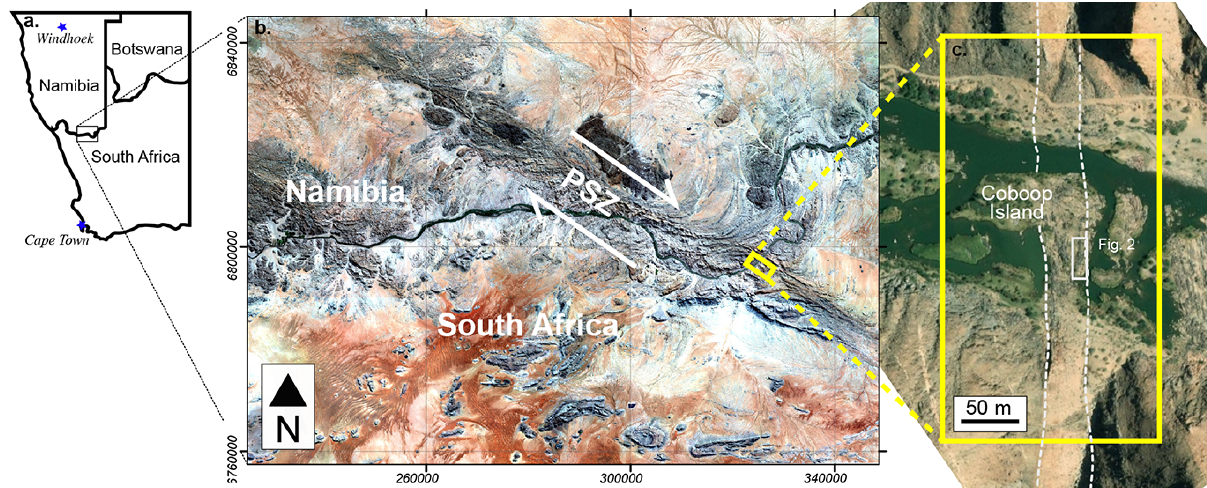
Figure 1. (a) Location of study area in the region. (b) Copernicus Sentinel-2 (2016) imagery of the southeastern Pofadder Shear Zone (PSZ) striking NW–SE where it crosses the Orange River (Namibia–South Africa border). Yellow rectangle indicates the location of (c) . (c) Coboop Island is only exposed at low water in the Orange River, so offers clean bedrock exposure. White dashed lines show approximate edges of shear zone core (Melosh et al., 2018, Fig. 2). White box shows location of high-resolution map of ultramylonite zone on the northeastern edge of the shear zone core (Fig. 2). Background image: ESRI World